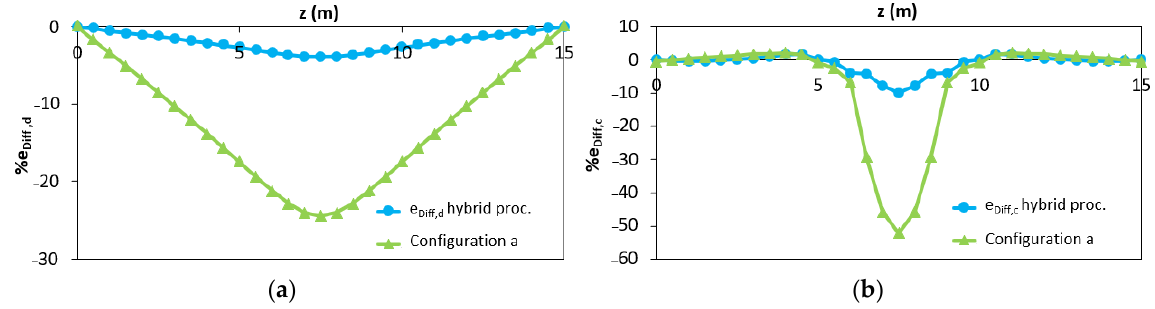
Figure 12. Distribution of the percentage difference in case of the hybrid procedure (blue curves) and without hybrid procedure (green curves) in ( a ) iFEM-predicted displacements; ( b ) iFEM-predicted curvature.